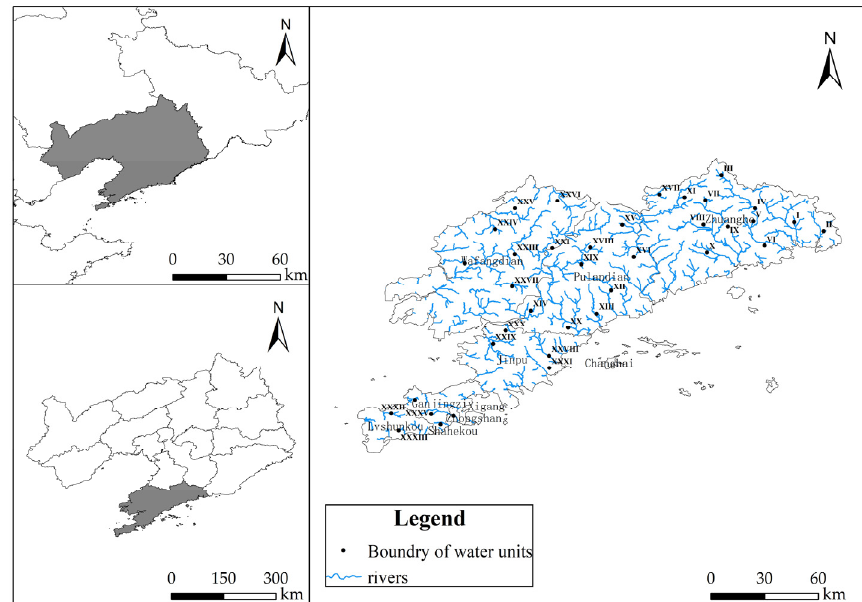
Figure 2. Geographical position and study regions of Dalian.